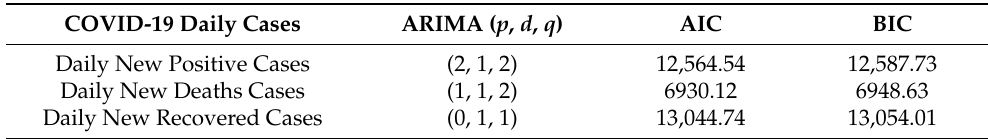
Table 2. The best ARIMA ( p, d, q ) model selection.